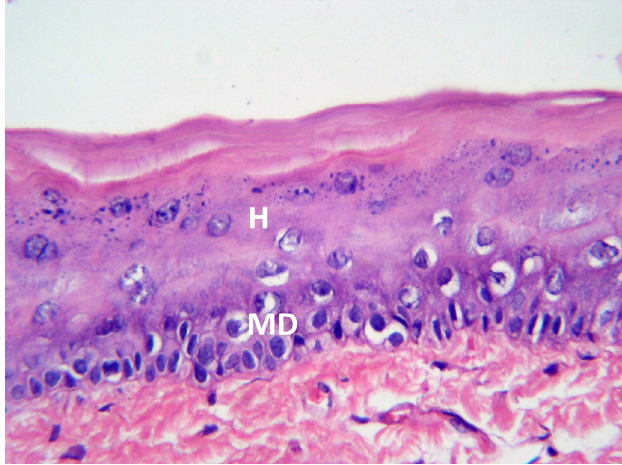
Fig. 2. Shows Hematoxylin and Eosin-stained cheek pouch section from a healthy untreated control animal. Normal thin keratinized strati fi ed squamous epithelium (E) on top of an unin fl amed connective tissue (CT) and a layer of normal striated muscles (SM). Magni fi cation: 20 (cid:1) .